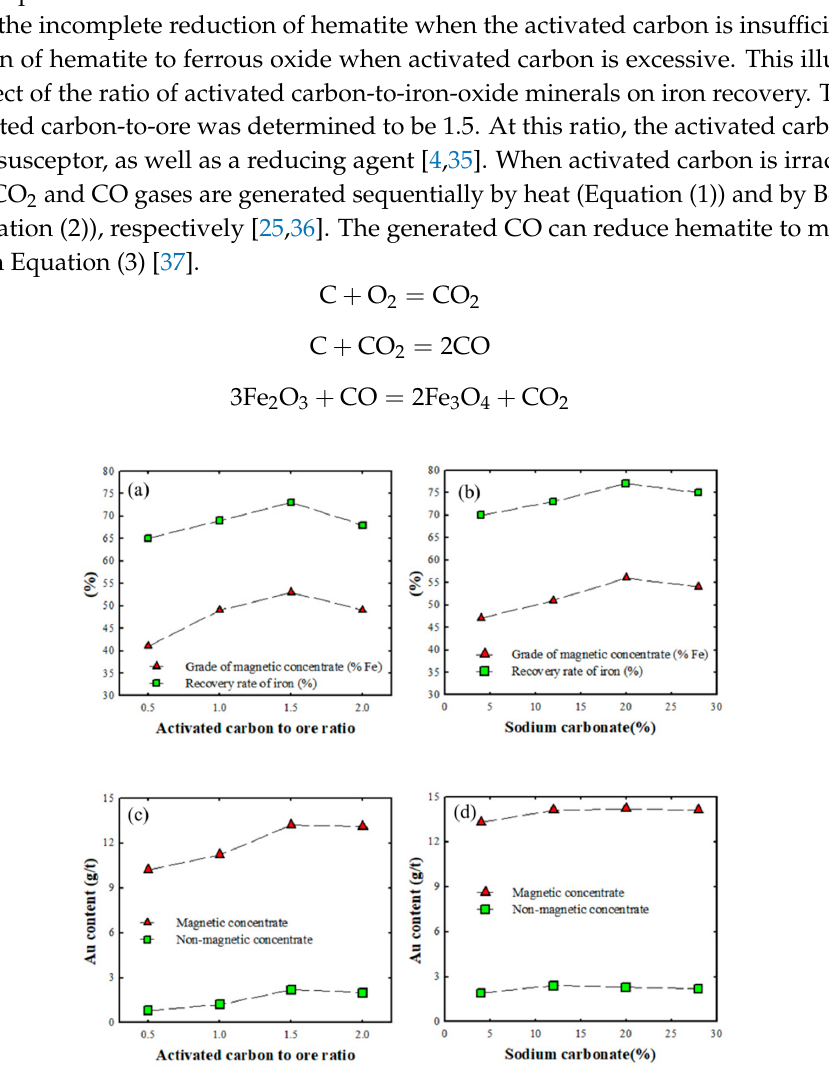
Figure 6. Effects of ( a , c ) activated carbon and ( b , d ) sodium carbonate concentrations on iron ( a , b ) and gold ( c , d ) recovery.